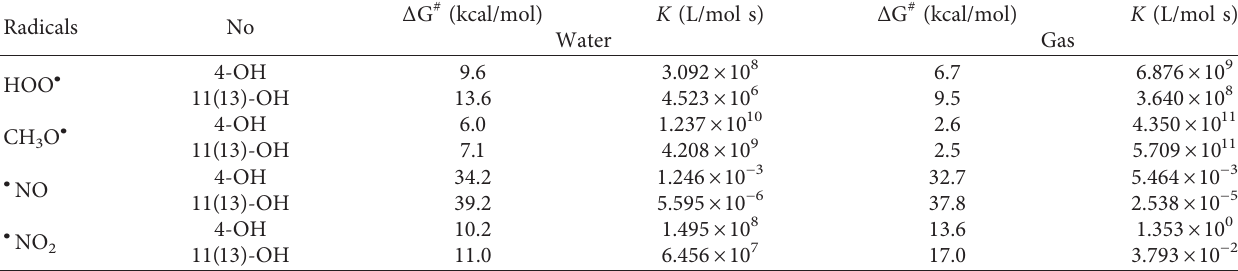
Table 5: ROS and RNS attack on hydroxy groups of RSV in gas and water (calculated Δ G # and K at the B3LYP/6-311++G(d, p) level of